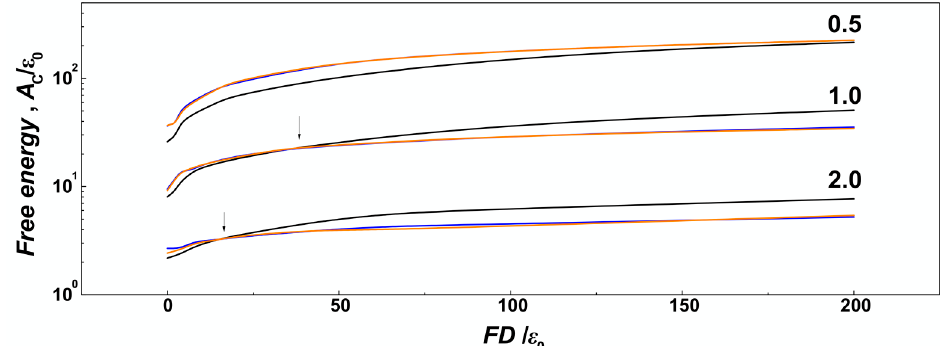
Figure 7. The confinement free energy during compression of DNA in helical and cylindrical nano- channels. In the plots, the black lines correspond to cylindrical channels, blue lines and orange lines to helical channels with negative −ω and positive + ω handedness respectively. Graph shows con- finement free energy A C , obtained as the integral of the number density of monomers on the surface of the channel in a layer δ = ⅕ σ thick. The regime of the confinement strength is indicated by the numbers along the lines in terms of the ratio D / P = 0.5, 1.0 and 2.0. The arrows indicate where the chain size bias is expected to take place in larger channels.